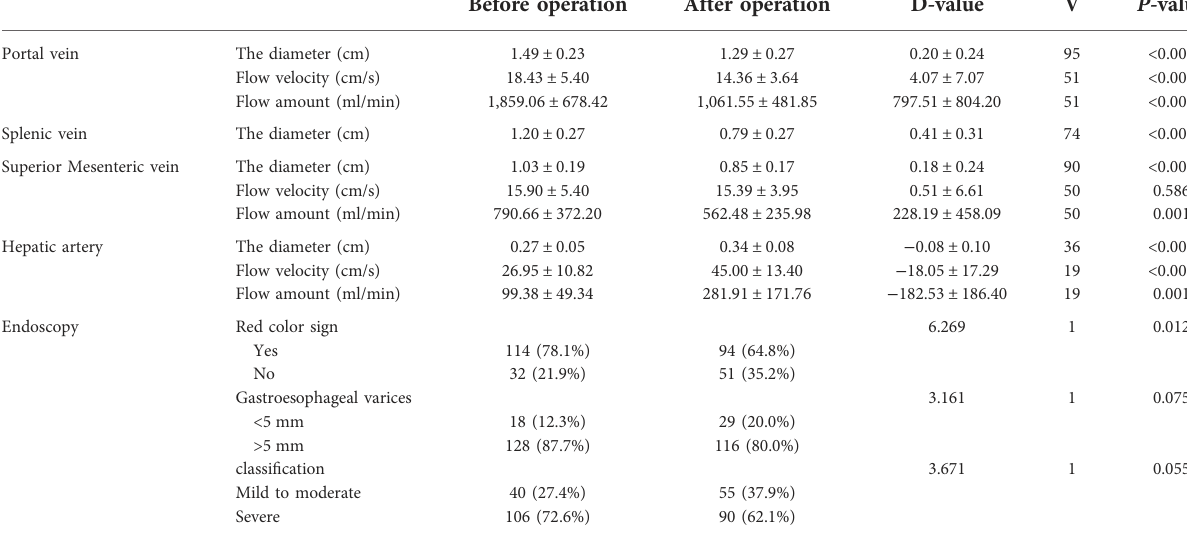
TABLE 5 Hemodynamic and endoscopic changes before and after operation ( n